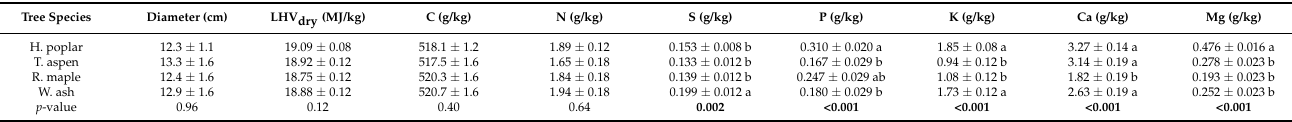
Table 3. Diameter and chemical properties (±S.E. of the mean) of unsplit firewood logs (110 cm in length). Means not 345 connected with the same letter are significantly different ( α = 0.05, Tukey’s HSD test). n = 12 for hybrid poplar and n = 6 346 for the other species. p -values in bold denote a significant effect.